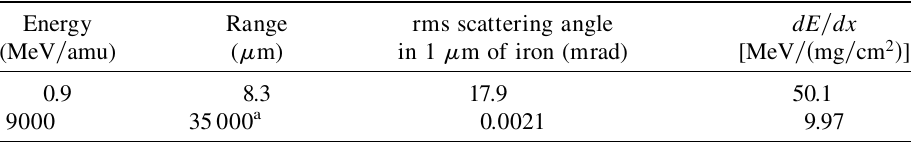
TABLE I. Interaction of gold beams with iron at Tandem and RHIC injection energies.